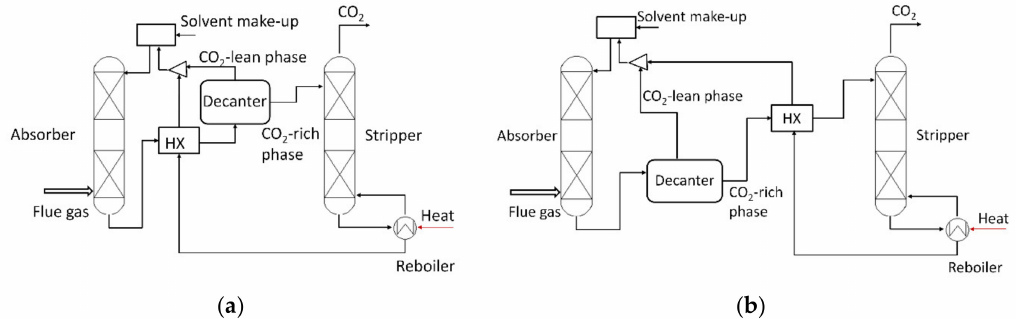
Figure 2. CO 2 capture flowsheet for phase-change solvents with phase separation ( a ) after the intermediate heat exchanger and ( b ) before the intermediate heat exchanger. The figures have been adapted from Zarogiannis et al. [13] with permission from Elsevier. HX: Heat